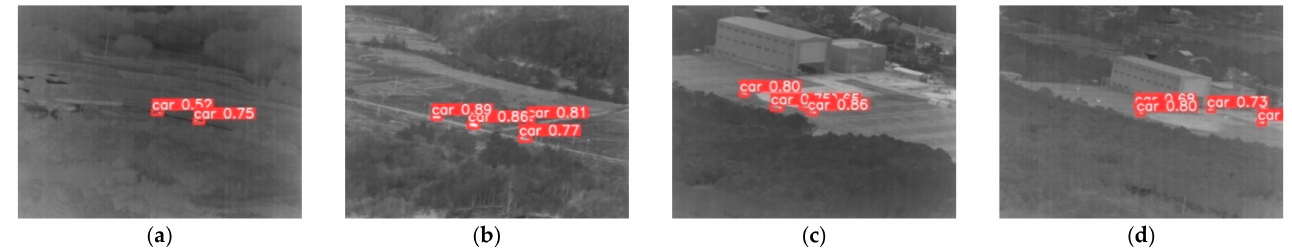
Figure 15. SE layer detection results. ( a ) Scene 1. ( b ) Scene 2. ( c ) Scene 3. ( d ) Scene 4.